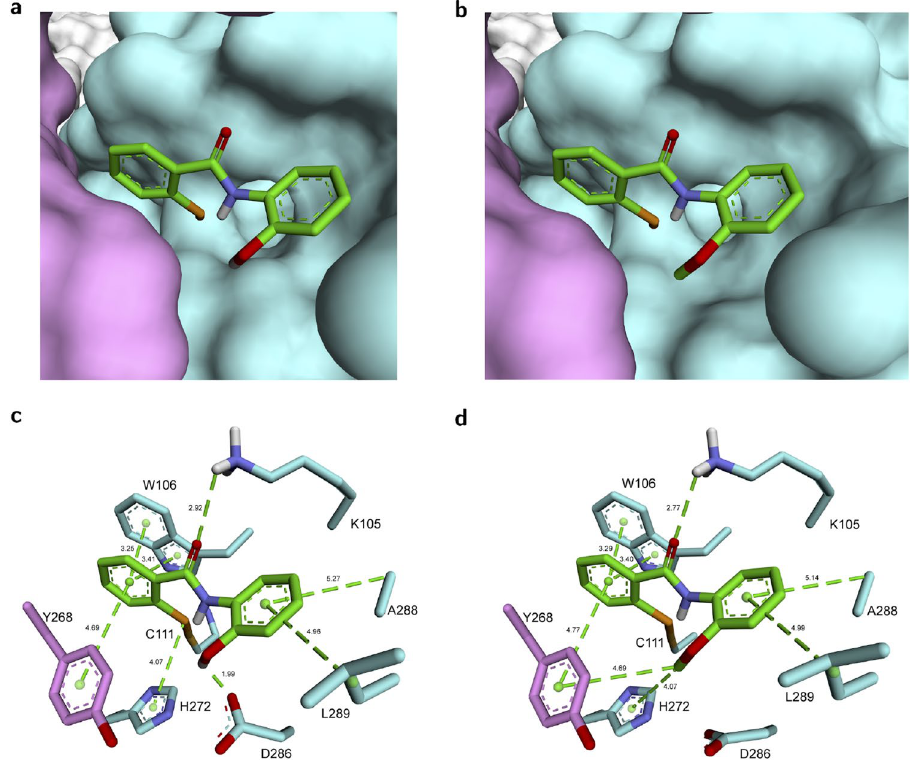
Figure 6. A model of the complex of hydroxyl and metoxyl derivatives with PL pro CoV2 shows additional interactions. ( a , b ) Molecular surface representation of the complex of 1d ( a ) and 1e ( b ) with PL pro CoV2 (PDB: 6W9C 37 ). ( c , d ) Stick representation of the interactions between 1d ( c ) and 1e ( d ) and residues in the active site of PL pro CoV2 (PDB: 6W9C 37